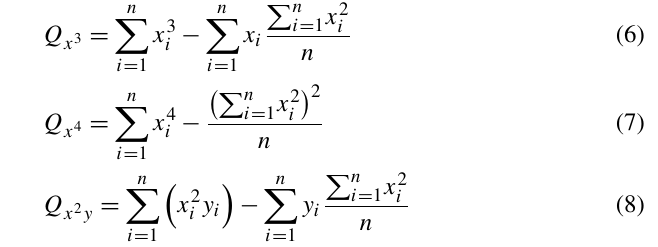
Table 3. Type of calibration curve, LODs and the method precision for each ion.